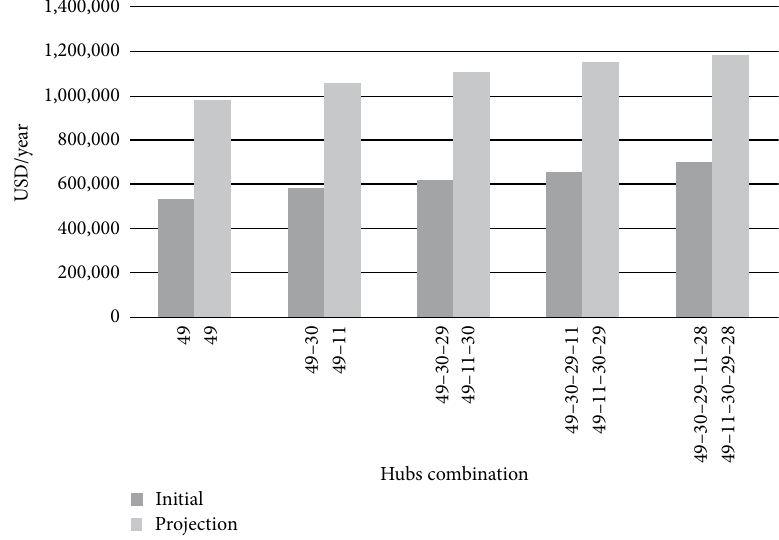
Figure 4: Transport savings by hubs opened, compared to the nonhub